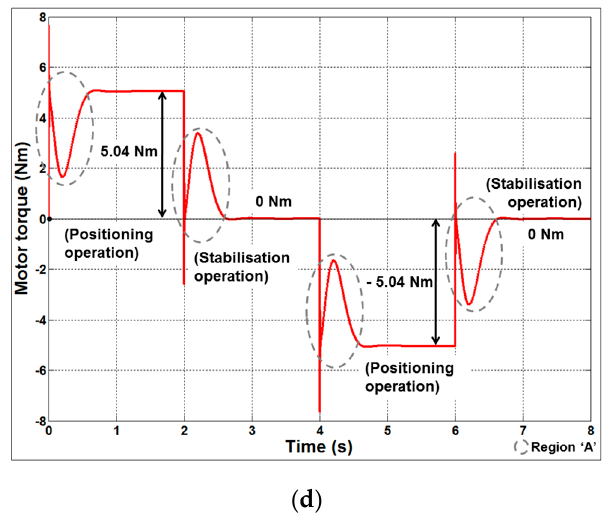
Figure 12. Staircase LATAX response of the autopilot. ( a ) Speed characteristics of the actuator for a staircase LATAX demand; ( b ) Autopilot LATAX with respect to missile fin angle for a staircase LATAX demand; ( c ) LATAX response of the autopilot for a staircase LATAX demand; ( d ) Torque exerted by the actuator on the missile fin for a staircase LATAX demand.